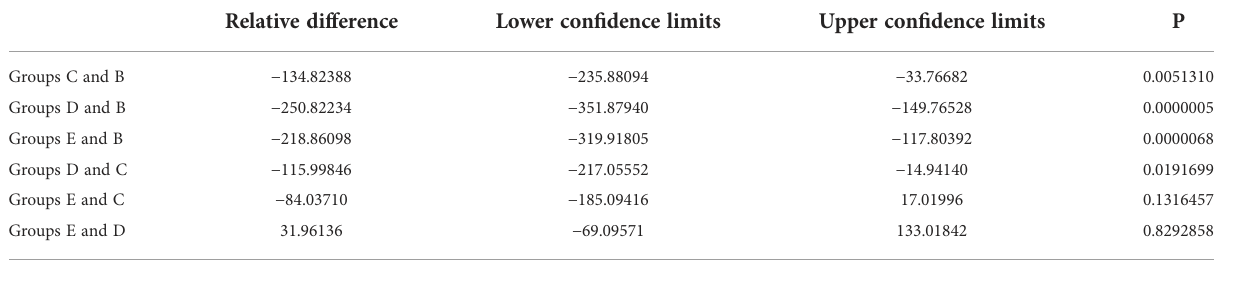
TABLE 8 Results of pairwise comparison of IFN- g .